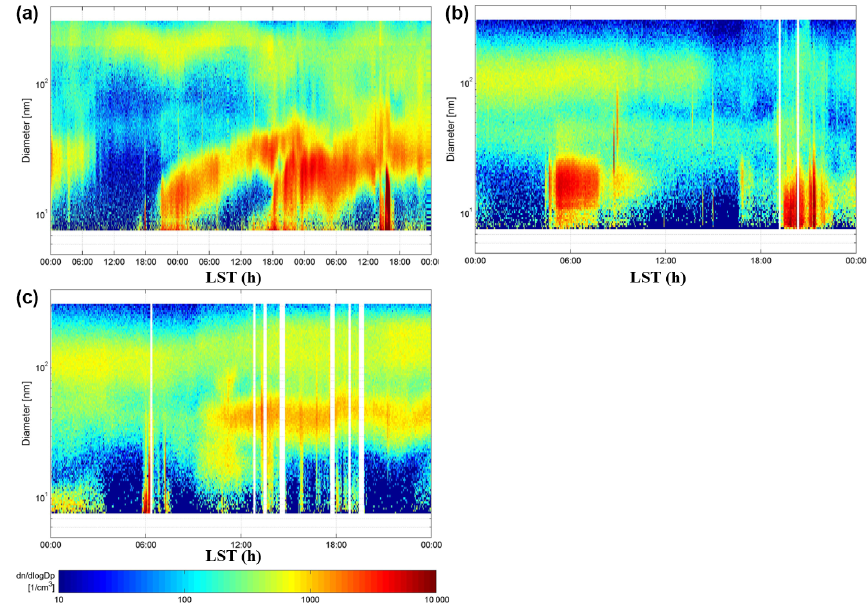
Figure 1. Example of types of the NPF based on the SMPS data. (a) Type A (18 January 2011–20 January 2011), (b) type B (13 January 2015) and (c) type C (9 January 2015). Type A is days when the formation and growth of nanoparticles should be clear. Type B is days when the formation occurred but growth was not clear. Type C is days when it cannot be said whether there is an event or